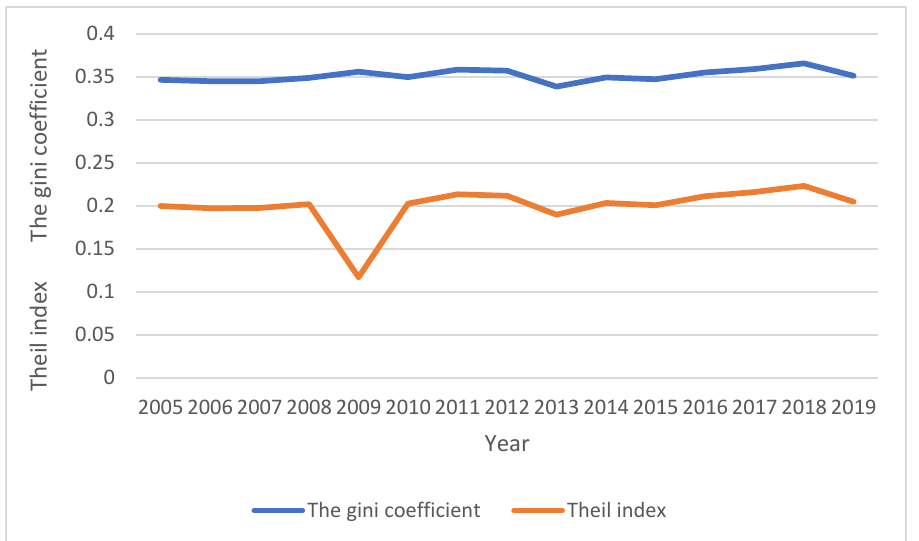
Figure 1. The Gini Coefficient and Theil Index of Per Capita Disposable Income of Rural Households in China from 2005 to 2019. Note: the data comes from the compilation and calculation of the Chinese Household Survey Yearbook.